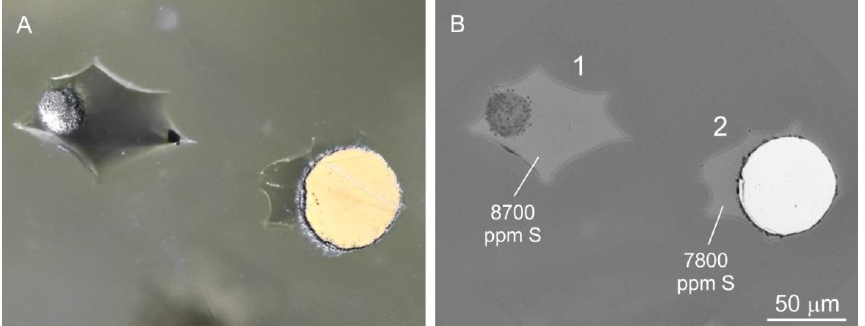
Figure 6. Transmitted light ( A ) and back-scattered electron ( B ) images of an adjacent MI in olivine, with and without sulfide globules. Inclusion #2 contains a large Fe-Ni sulfide globule, whereas inclusion #1 only contains a contraction bubble. Both inclusions are represented by transparent glass. Notably, sulfur concentrations in the sulfide-free inclusion #1 reach 8700 ppm, which is higher than those from the sulfide-hosting inclusion #2 (7800 ppm).